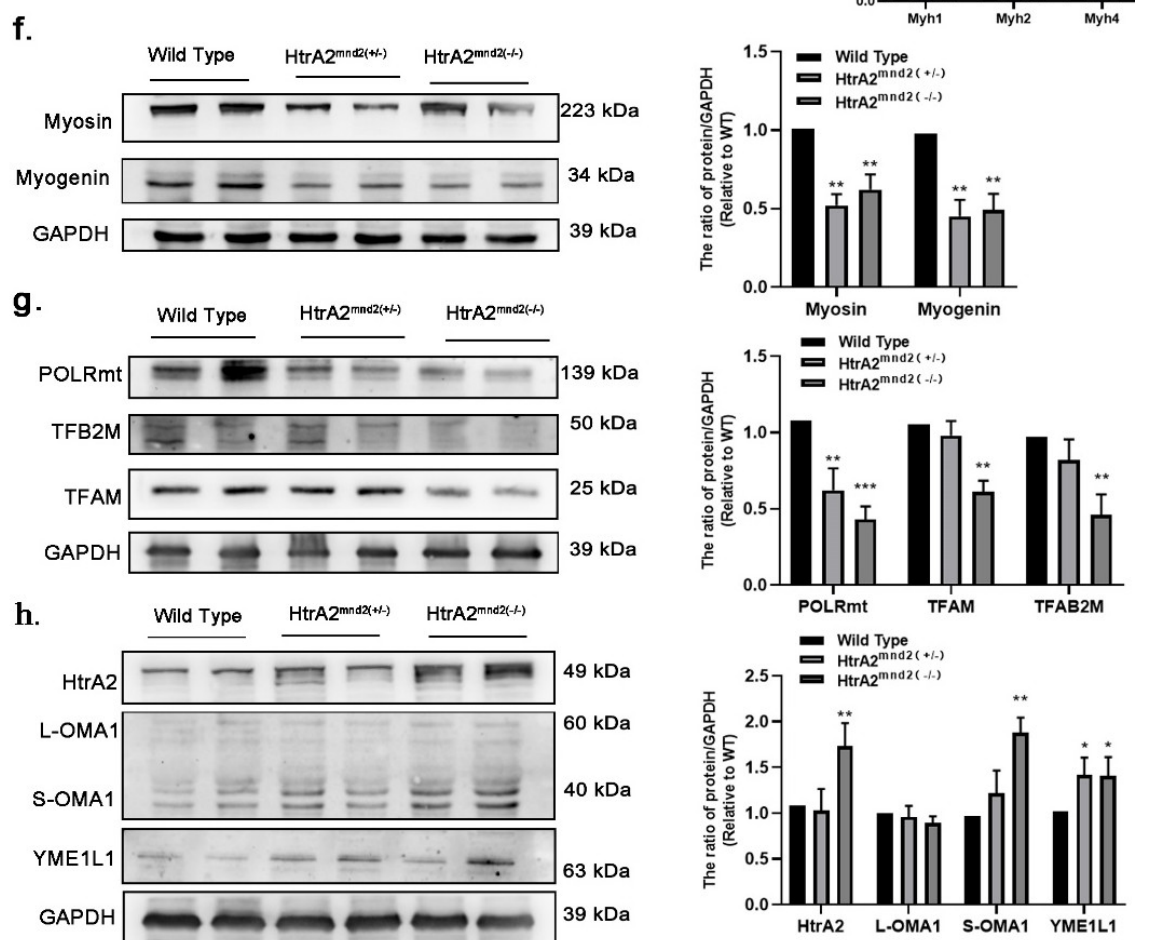
Figure 1. Gastrocnemius muscle tissue from HtrA2 mnd2(−/−) mice exhibiting a sarcopenic phenotype. ( a ) Agarose gel electrophoresis graphs of genotype identification, fluorescence of DNA fragments under UV for the three genotypes. ( b ) Thirty-five-day-old mice corresponding to genotype WT (left), HtrA2 mnd2(+/−) (middle), and HtrA2 mnd2(−/− ) (right). ( c ) HE staining of cross-sections of gastrocnemius muscle tissues from mice with the three genotypes and high-throughput semiautomatic muscle fiber CSA analysis by Open-CSAM. A total of 86 WT, 131 HtrA2 mnd2(+/−) , and 123 HtrA2 mnd2(−/−) muscle fibers were identified and analyzed. ( d ) The CSA of HtrA2 mnd2(+/−) and HtrA2 mnd2(−/−) myofibers was significantly smaller compared to WT group mice. ( e ) RT-qPCR detection of mRNA transcript levels of Myh1, 2, 4, and 7 in gastrocnemius muscle of three genotypes of mice ( n = 6). ( f ) Western Blot assay of expression of Myosin and Myogenin, marker proteins of myogenic differentiation, and quantification of western blots in gastrocnemius tissue of mice of the three genotypes ( n = 6). ( g ) Western Blot assay of mitochondrial DNA binding proteins POLRmt, TFAM, and TFB2M expression and quantification of western blots in gastrocnemius muscle tissues of three genotypes ( n = 6). ( h ) Western Blot detection of IMS proteases HtrA2, YME1L1, and OMA1 expression and quantification of western blots in gastrocnemius muscle tissues of three genotypes ( n = 6). Two-tailed unpaired Student’s t -tests were used. Statistical significance: * p ≤ 0.05, ** p ≤ 0.01, *** p ≤ 0.001. Scale bar: 50 μm. CSA, cross-sectional area; WT, wild type; RT-qPCR, real time quantitative PCR; HE, Haematoxyline and eosin stain; Myh, myosin heavy chain; POLRmt, RNA polymerase mitochondrial; TFAM, transcription factor A, mitochondrial; TFB2M, transcription factor B2, mitochondrial; HtrA2, high temperature requirement protein A2; OMA1, OMA1 zinc metallopeptidase; YME1L1, i-AAA protease YME1 L1; mnd2, motor neuron degeneration 2 mutant.